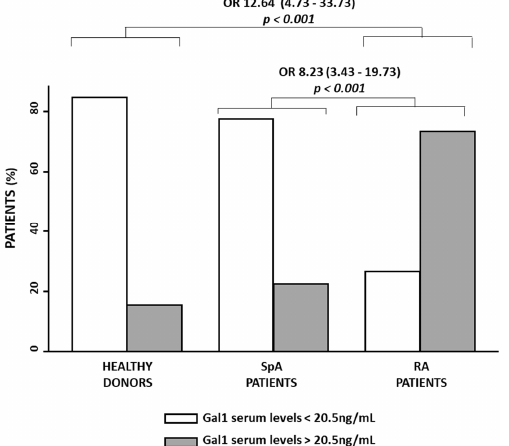
Figure 3. Gal1 serum levels could differentiate between rheumatoid arthritis patients and spondy ‐ loarthritis patients or healthy donors. Comparison of the percentage of patients with low Galectin ‐ 1 (Gal1) serum levels (white bar) versus patients with high Gal1 serum levels (grey bar) in the dif ‐ ferent study subpopulations. The cut ‐ off for discriminating high and low Gal1 serum levels was 20.5 ng/mL, as described in the results section. Odd Ratio (OR) and its Confidence Interval (CI) were estimated with the logit command of Stata 14.1. The model was adjusted by sex and age. Significance threshold was set at p ‐ value <0.05.